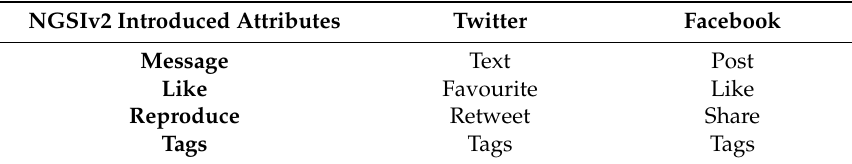
Table 2. Introduced NGSIv2 Attributes assigned to “SocialMediaContent” Entity and their mapping to dominant social media platforms.